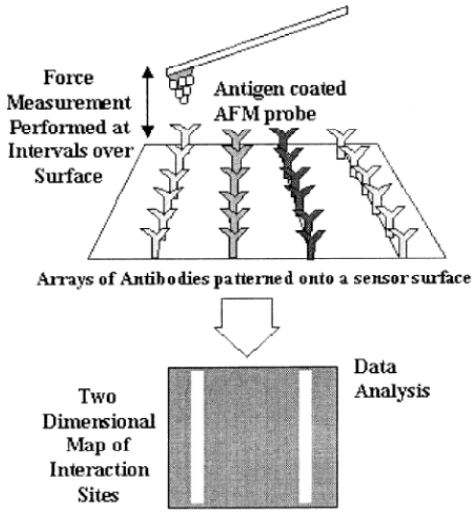
Figure 4. A schematic diagram of an antigen-coated probe mapping specific interaction sites on a substrate patterned with three antibody species (reprinted from [26] with